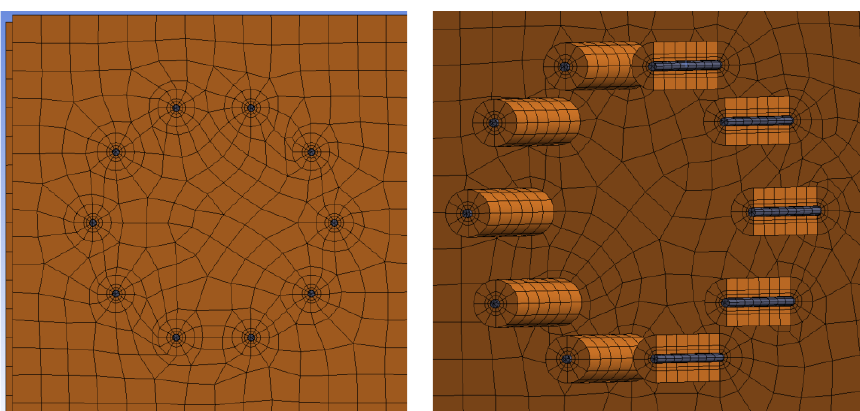
Figure 11. Finite element mech for Experiment B, fully threaded screws.